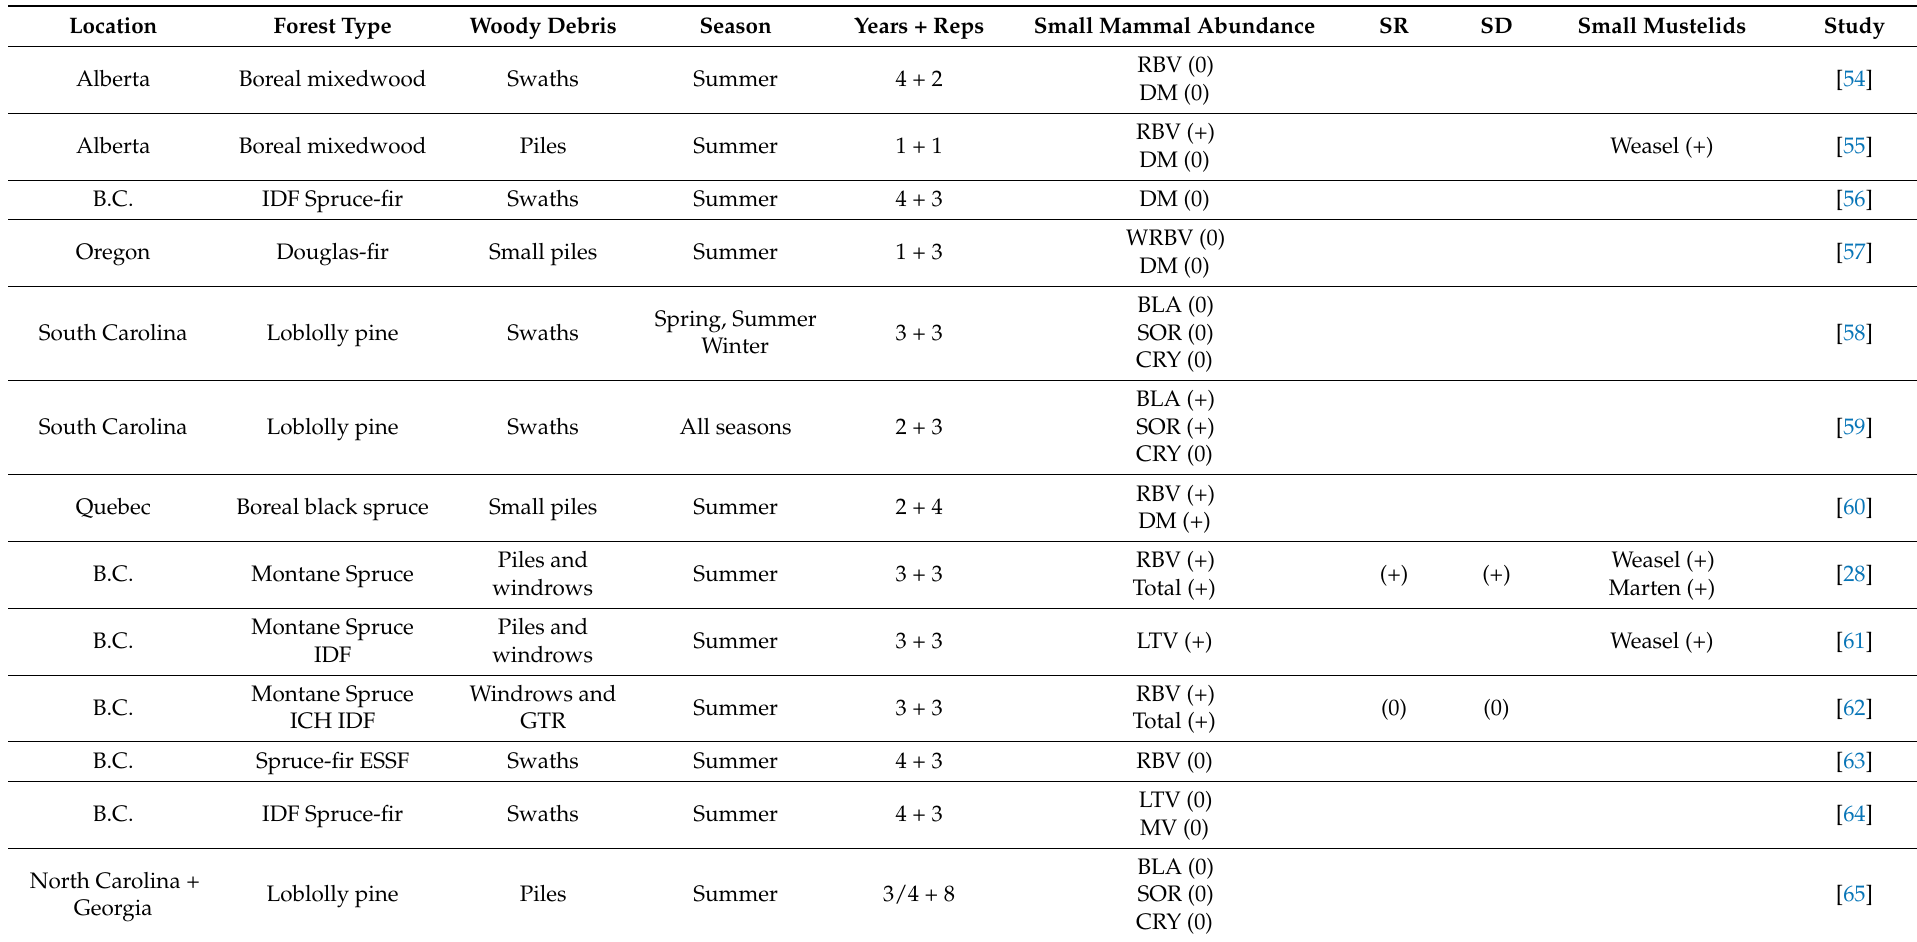
Table 1. Summary of mammal studies with construction of postharvest woody debris habitats (experimental manipulations) in several forest ecological zones. Forest-floor small mammals include the major species and small mustelids include marten, short-tailed weasel, and long-tailed weasel. Responses to woody debris structures are (-) negative, (0) neutral, or (+)